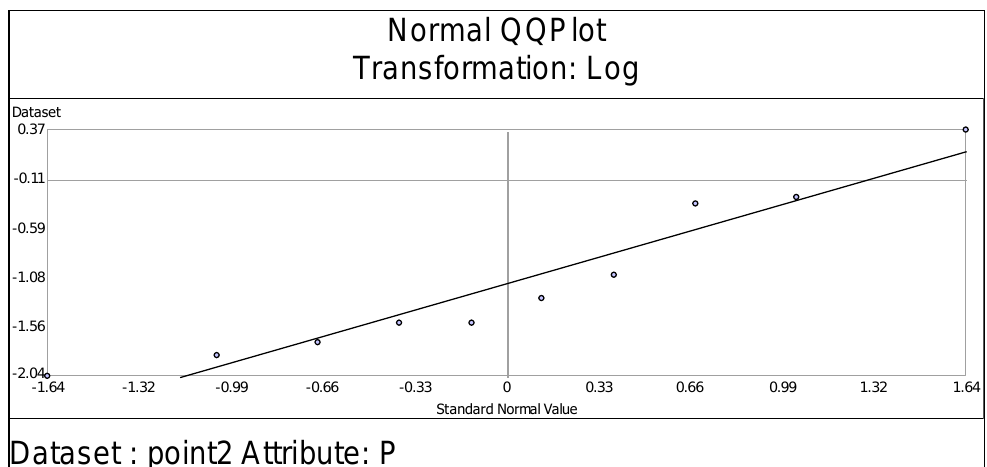
Figure 2. Probability-probability plots of groundwater phosphate